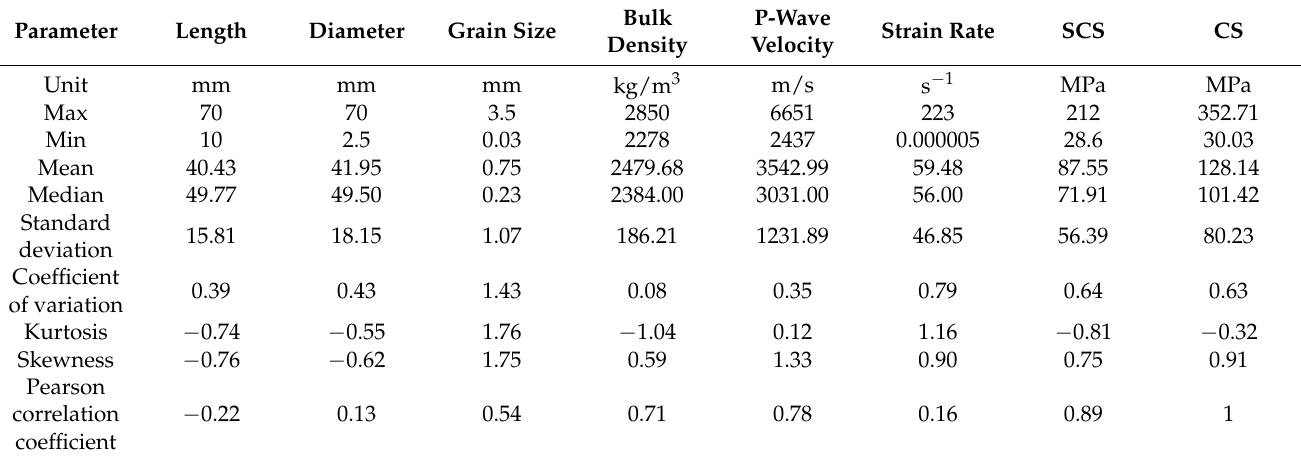
Table 1. Distribution characteristics of the parameters.